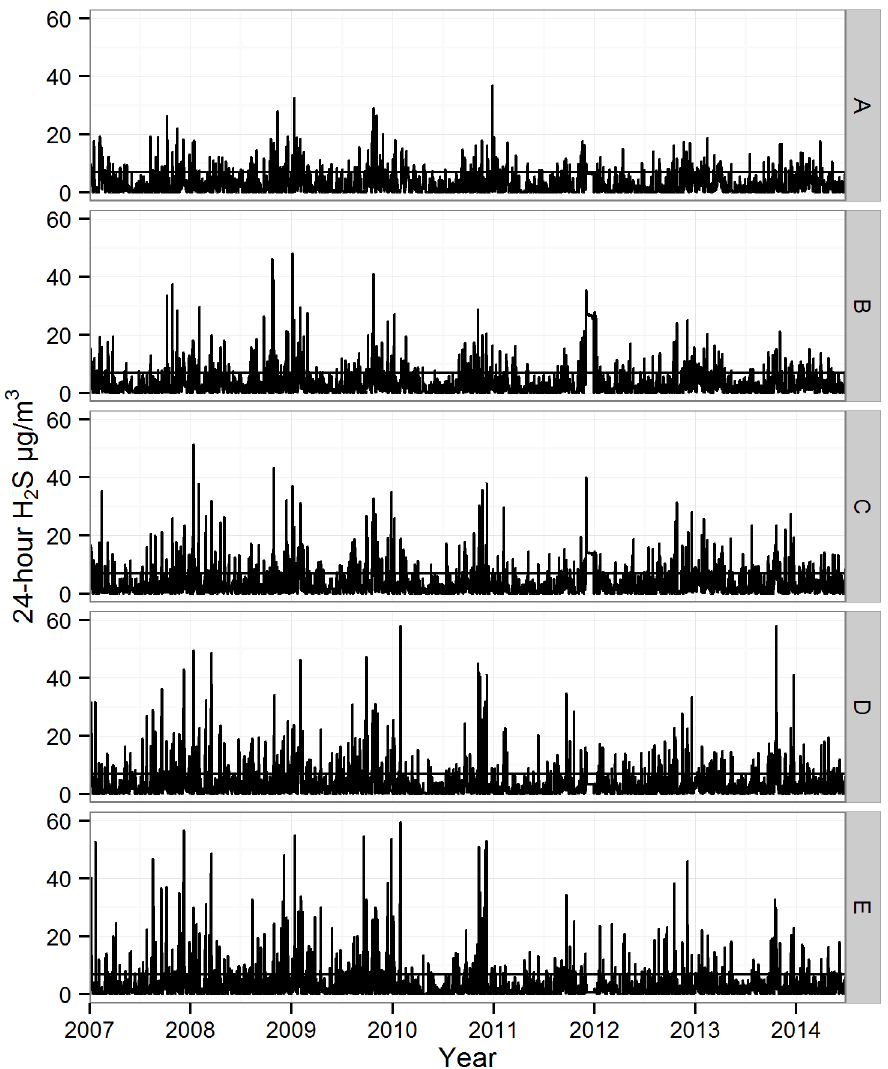
Fig 2. Daily 24-hour concentrations of H 2 S in μ g/m 3 within modelled sections A to E of the Reykjavik capital area over the study period 1 January, 2007 – 30 June, 2014. Horizontal line indicates the 85 percentile limit of 7.00 μ g/m 3